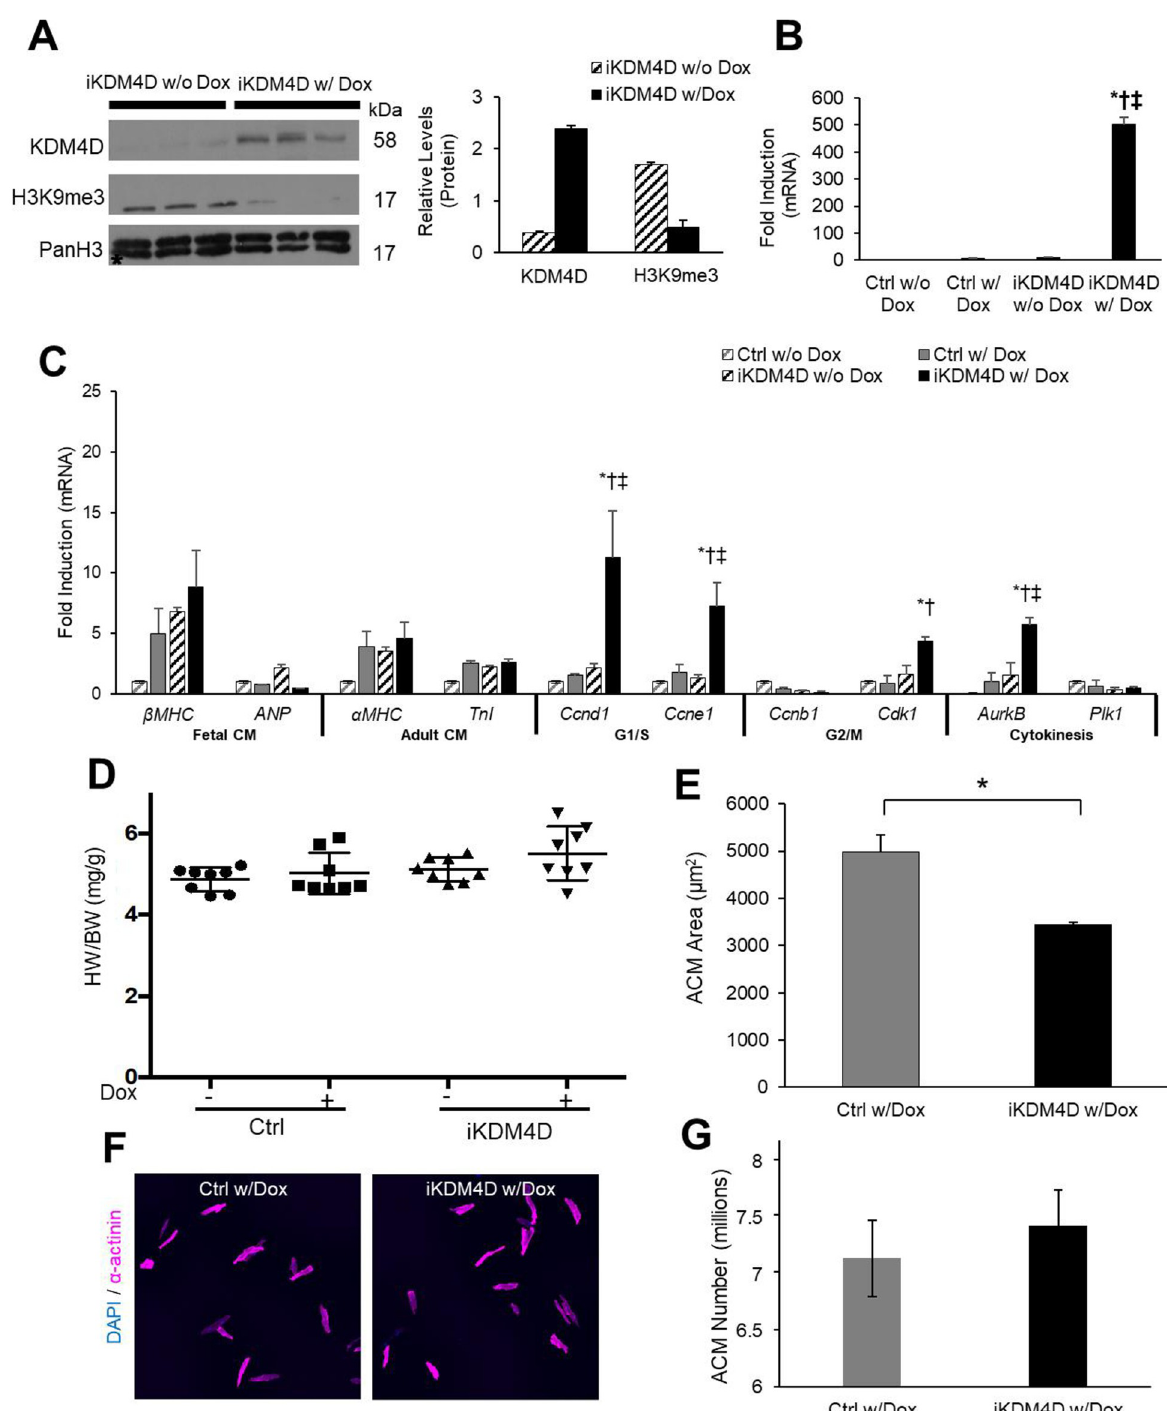
Fig 4. Inducible KDM4D mouse model. (A) Immunoblotting of ACM lysates (left) showing CM-specific KDM4D protein induction in iKDM4D hearts and depletion of H3K9me3 with two weeks of induction in ACMs. Densitometry analysis (right) shows KDM4D, and H3K9me3 levels relative to PanH3 control in iKDM4D CMs with (n = 3) and iKDM4D CMs without (n = 3) doxycycline induction. � p < 0.05. (B) KDM4D transgene expression is robustly induced in iKDM4D ACMs fold induction vs. control (-Dox), expression normalized to Gapdh. (C) Expression of CM and cell cycle genes in isolated ACMs measured by qRT-PCR, fold induction vs. control (-Dox), expression normalized to Gapdh. (D) HW/ BW quantification in uninduced control and iKDM4D mice (-Dox) and induced in control and iKDM4D (+Dox). (E, F, G) Quantification of ACM